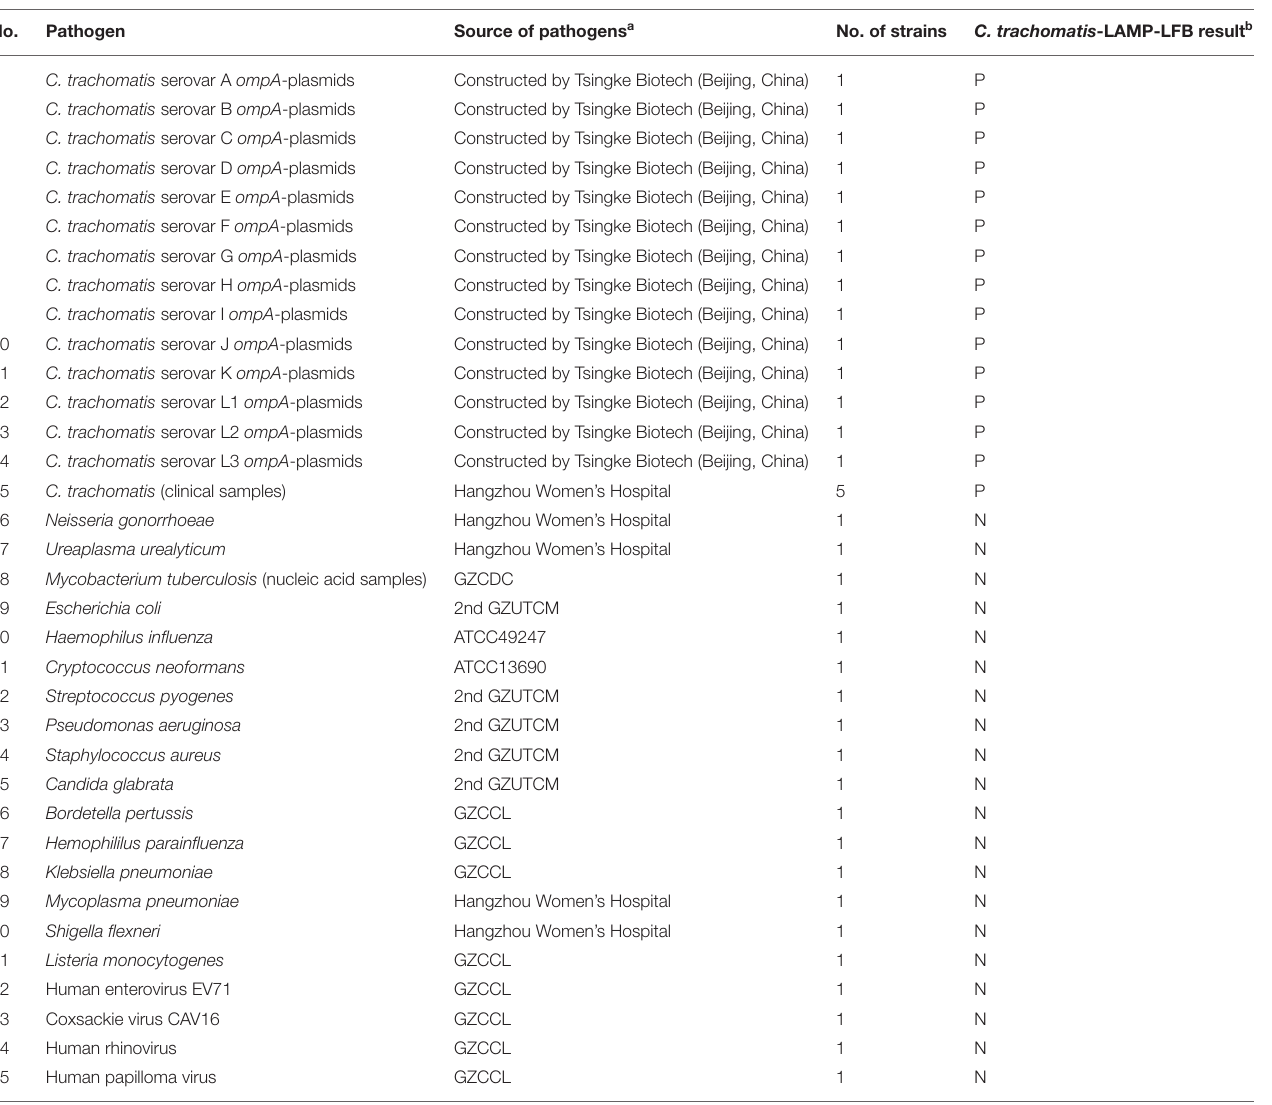
TABLE 2 | Pathogens used in this study.